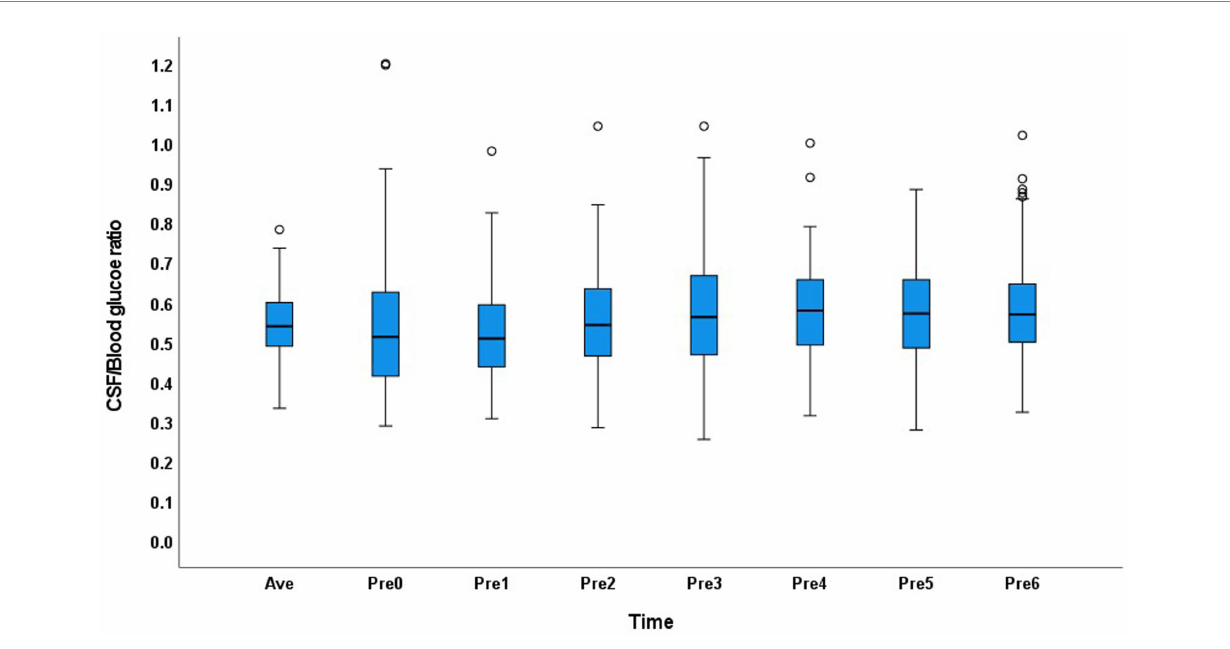
FIGURE 2 Distribution of the cerebrospinal fluid/blood glucose ratio of each group and the average value in the abnormal glucose metabolism group.